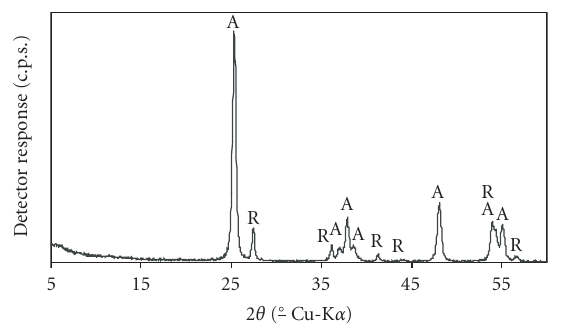
Figure 2: XRD patterns of aggregates of TiO 2 particles (A: anatase and R: rutile).